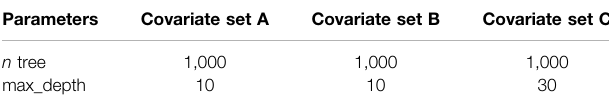
TABLE 3 | Parameters of